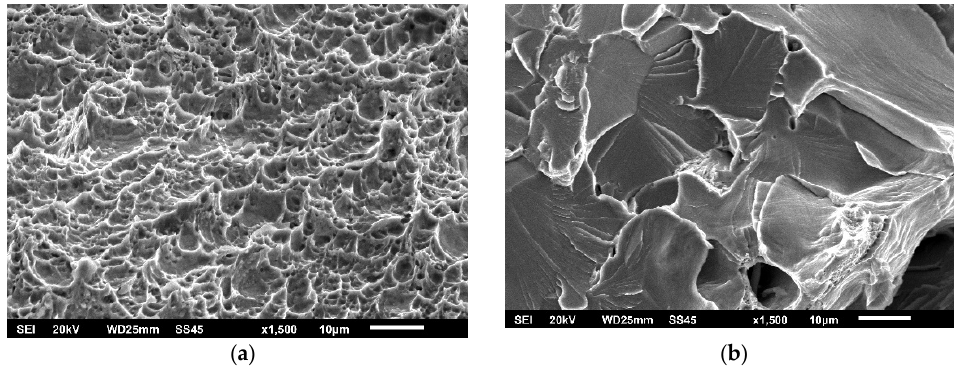
Figure 15. SA ‐ 387 Gr. 91 BM fractography. ( a ) SENB specimen 20 °C, ( b ) CT specimen 575 °C, 1500×. Figure 15. SA-387 Gr. 91 WM fractography. ( a ) SENB specimen 20 ◦ C, ( b ) CT specimen 575 ◦ C, 1500 ×